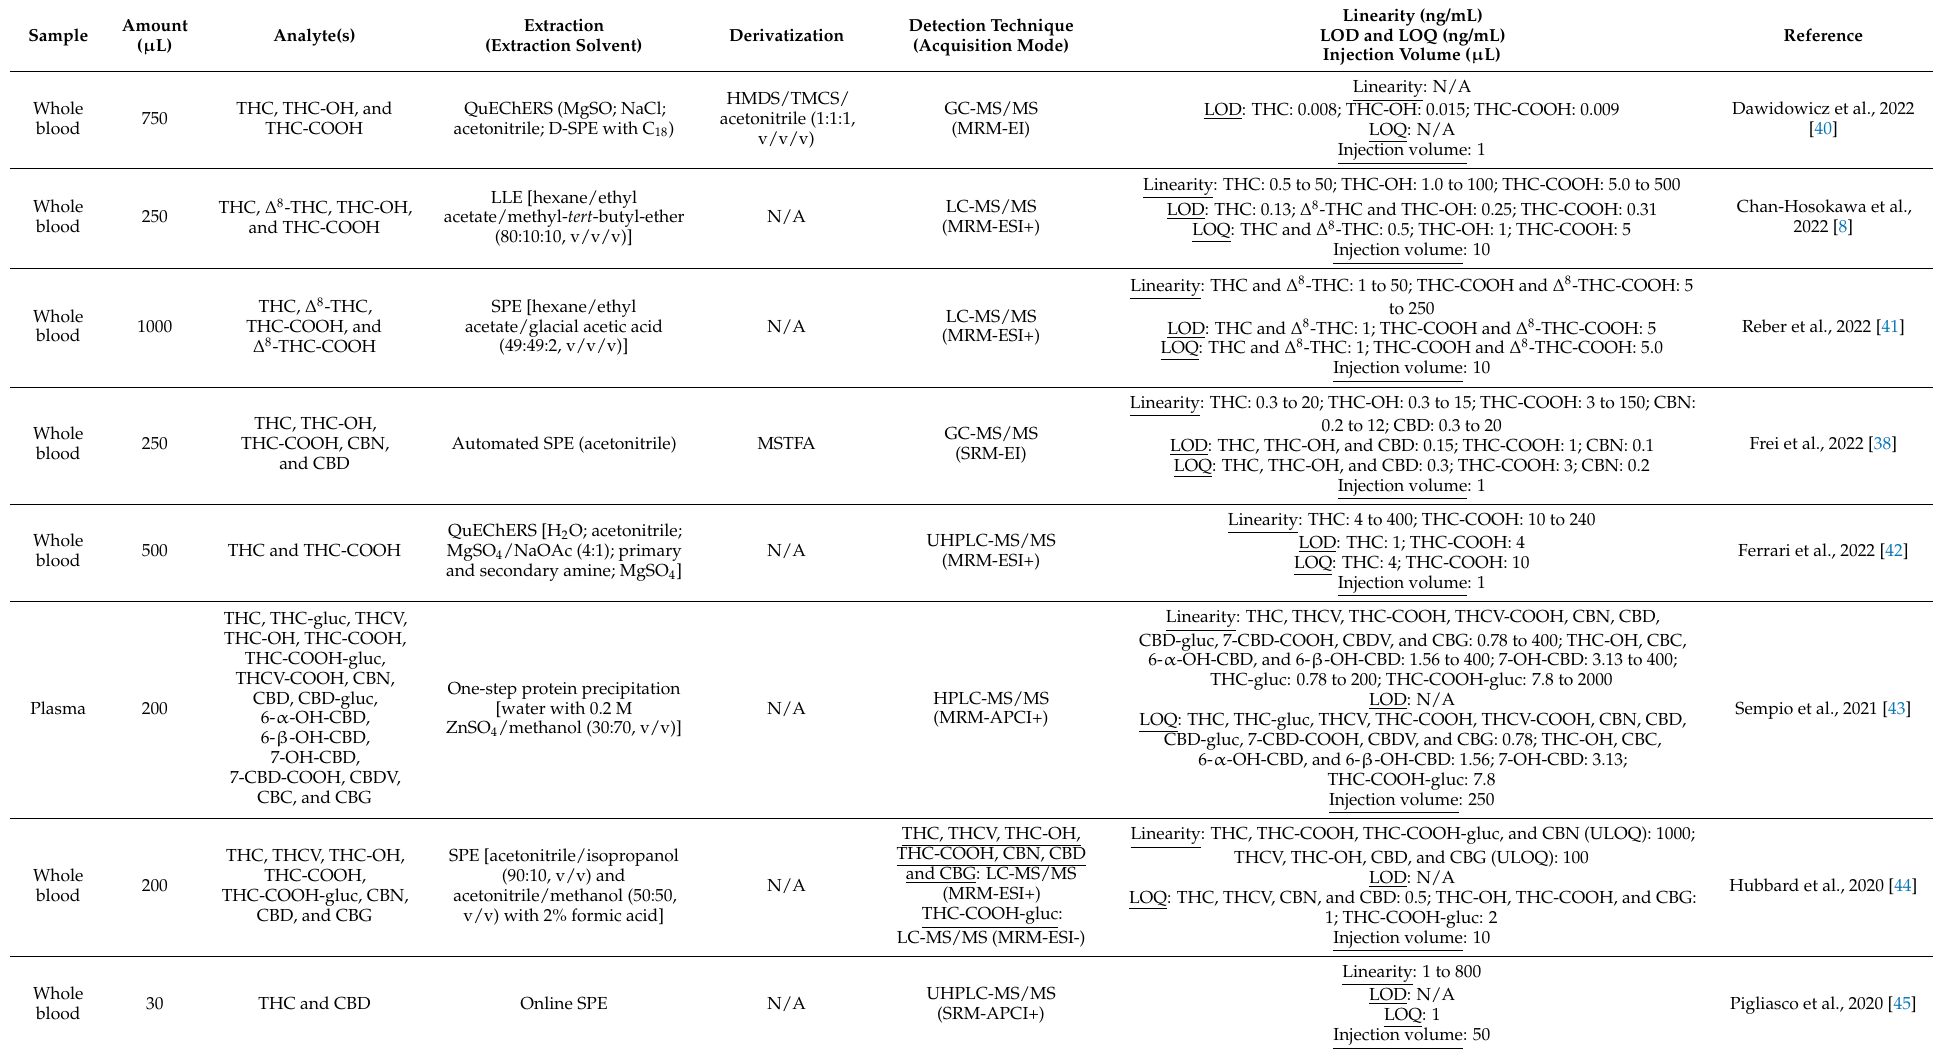
Table 1. Methods for the identification and quantification of cannabinoids in whole blood, plasma, and